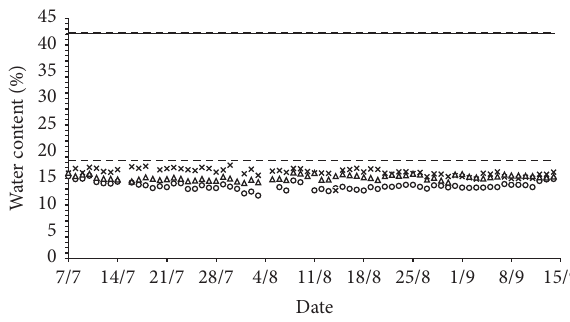
Figure 8: Temporal soil water content variation in the soil depth +Δ𝜃 −Δ𝜃 𝑍 = 70 cm: at the inlet 𝑋 = 0 ( × ), at the behalf 𝑋 = 𝐿/2 ( 󳵻 ), and at ) solid and ( 𝜃 ) op op op op the lateral end tip 𝑋 = 𝐿 (o)against ( 𝜃 dashed lines.